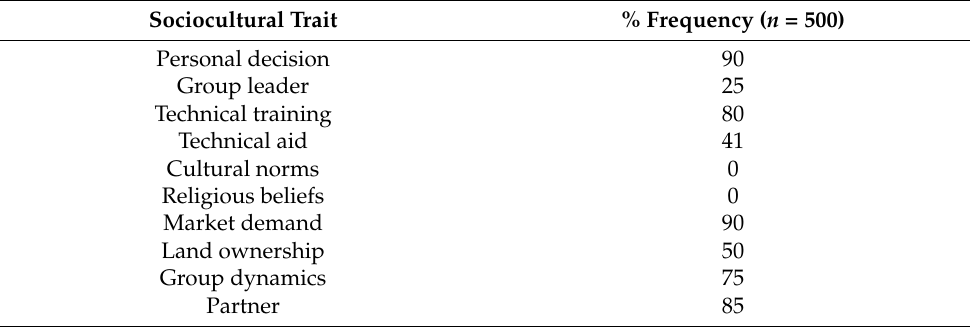
Table 3. Social factors influencing conservation agriculture adoption by individuals.